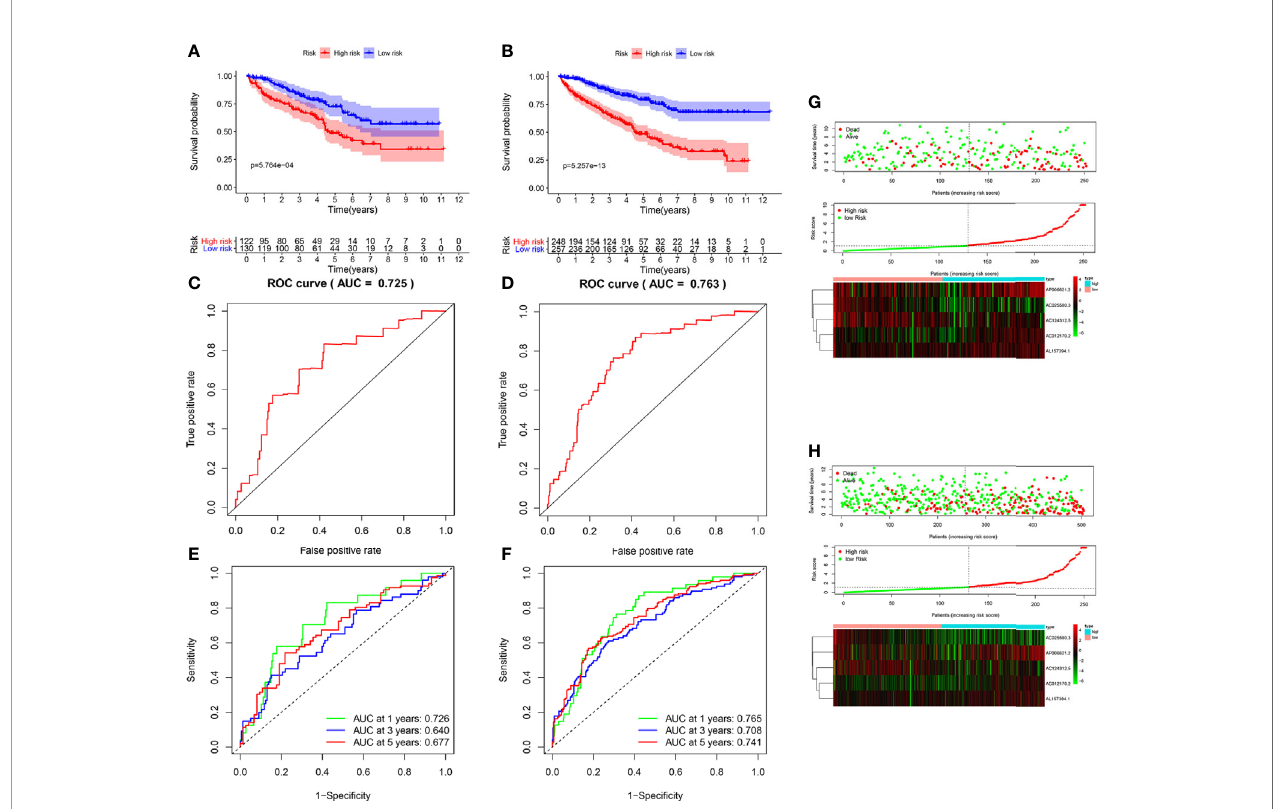
FIGURE 3 | Validation of the prognostic signature for KIRC patients in testing set and overall set. Kaplan-Meier curves showed that the high-risk group had worse overall survival (OS) than the low-risk group in the testing set (A) and overall set (B) . Receiver operating characteristic (ROC) curves for the prognostic signature and its AUC value in the testing set (C) and overall set (D) . ROC curves and their AUC value represented 1-, 3-, and 5-year predictions in the testing set (E) and overall set (F) . Scatter dot plot showed the outcomes between the survival status and risk score of KIRC patients in high- and low-group; Risk score distribution plot showed the distribution of high-risk and low-risk KIRC patients; Heatmap of the fi ve m6A-related lncRNA expression pro fi les showed the expression of risk lncRNAs in high-risk and low-risk group in the testing set (G) and overall set (H) ,